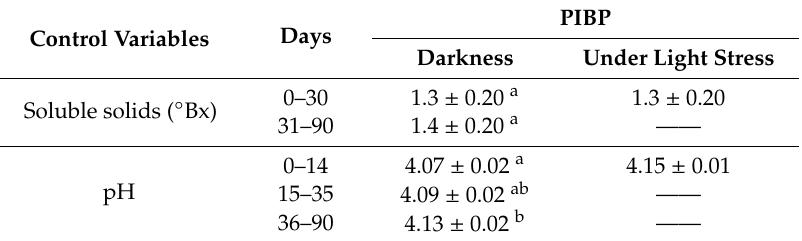
Table 4. Obtained values in some control variables of the prototype isotonic beverage pigmented (PIBP) stored in darkness and under light